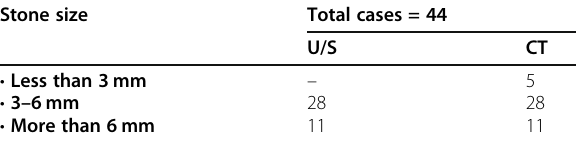
Table 1 Patient characteristics Patient